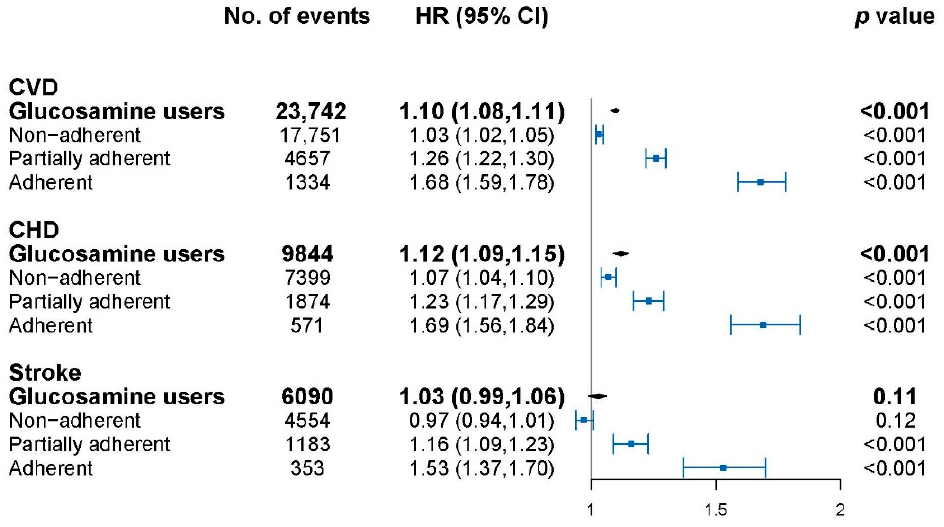
Figure 1. Association of glucosamine users with cardiovascular disease (CVD) at different adherence levels. CVD, cardiovascular disease; CHD, coronary heart disease; HR, hazard ratios; CI, confidence interval. HRs were calculated compared with glucosamine non-users, and were adjusted for age, sex, hypertension, medication, Charlson Comorbidity Index (CCI), and health care utilization index (HCUI). The dots indicate the HRs and the lines between bars represents the 95% confidence intervals. The subgroup analysis for CVD is shown in Table S4. The similar trends among the glucosamine users with different adherence were found when stratified by sex or age ( p for trend < 0.001 for